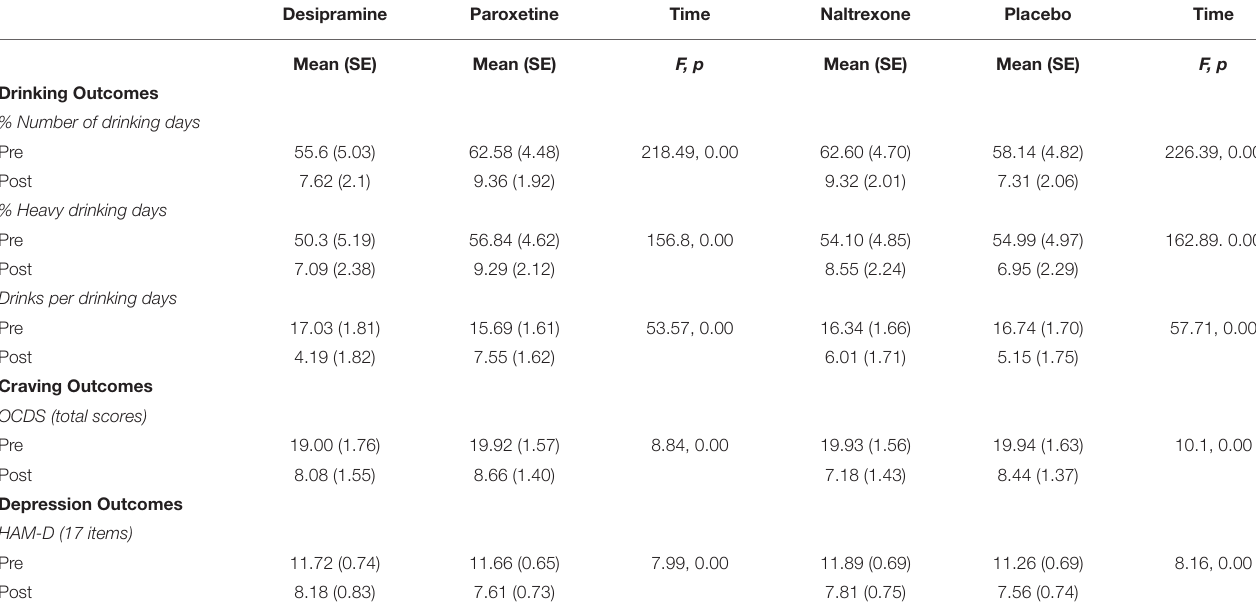
TABLE 2 | Drinking, craving, and depression outcomes at beginning and end of